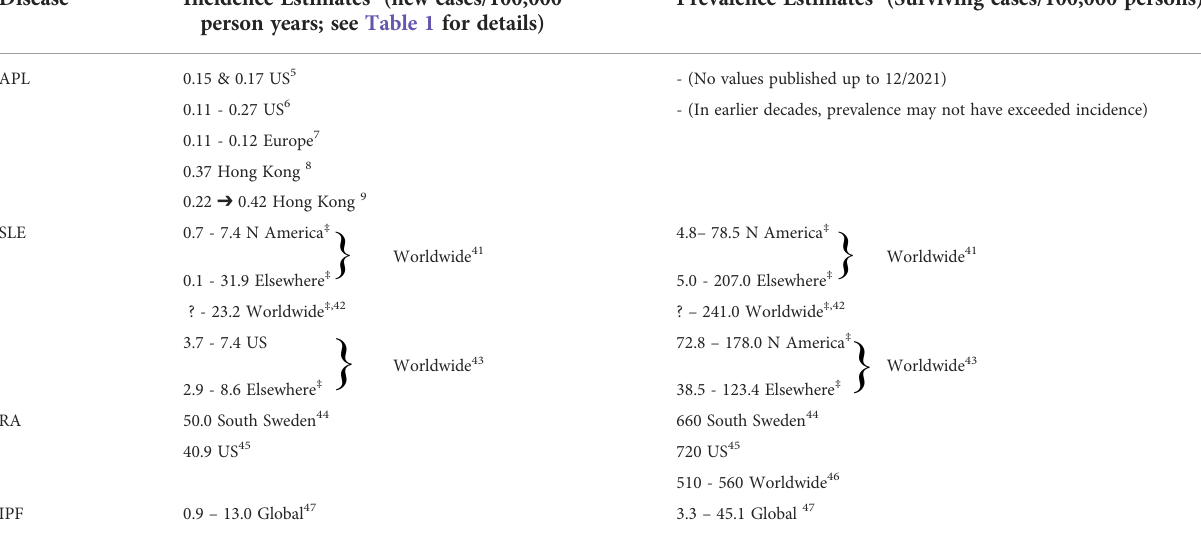
TABLE 2 The epidemiology of acute promyelocytic leukaemia and other possible high pro fi le arsenic trioxide responsive diseases. Disease Incidence Estimates † (new cases/100,000 person years; see Table 1 for